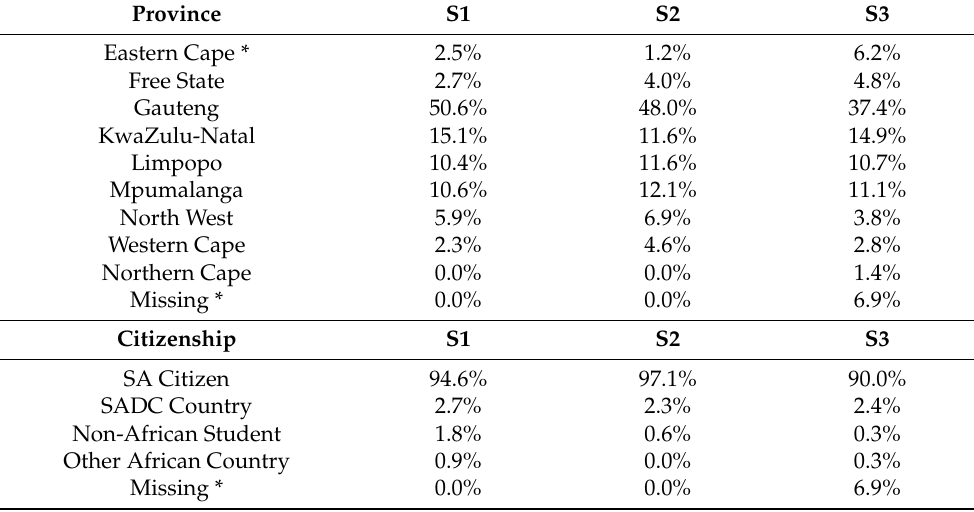
Table 1. Cross-tabulation of biographical variables (% within